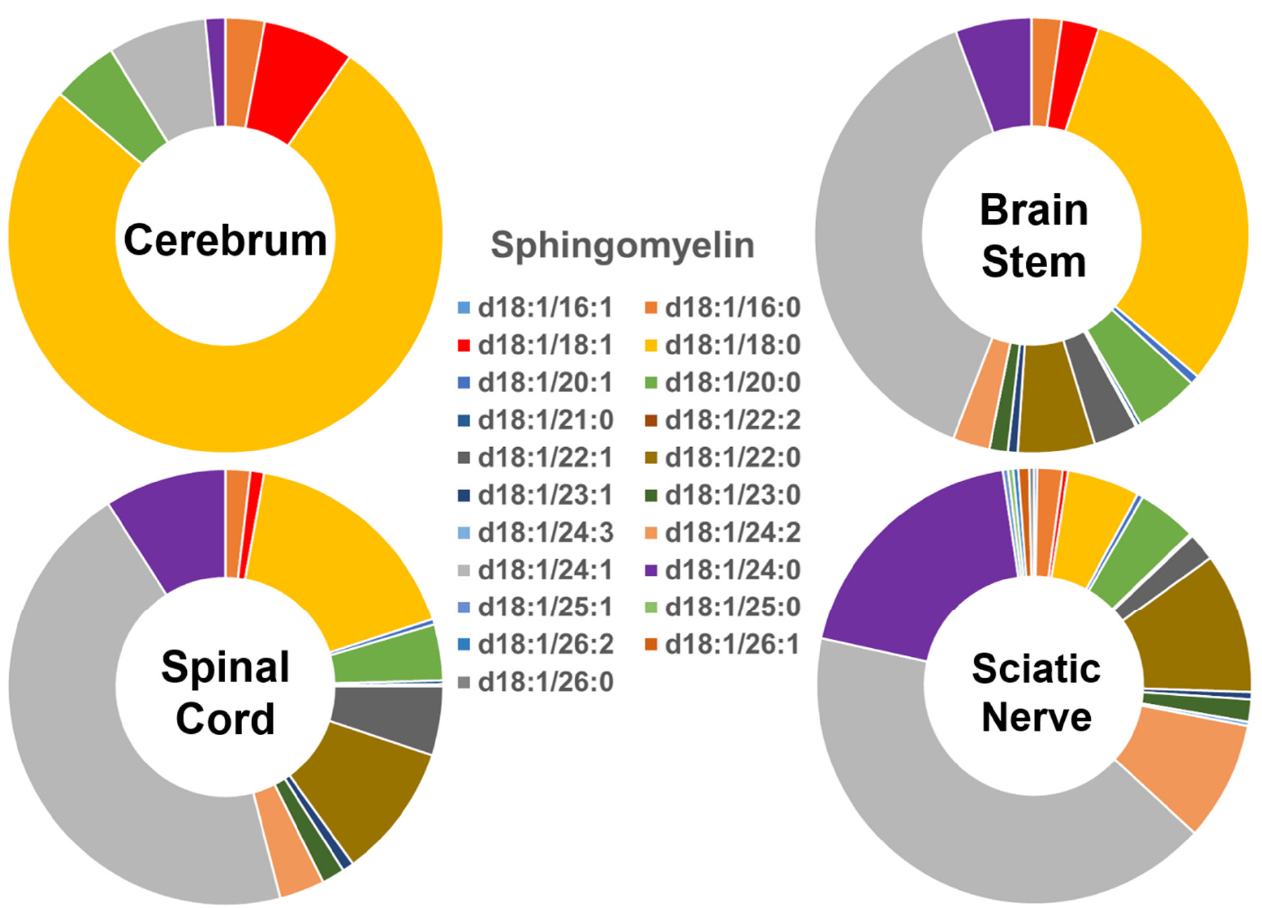
Figure 2. Comparison of sphingomyelin molecular species profiles in cerebrum, brain stem, spinal cord, and sciatic nerve tissues from 2 mo-old mice. Levels of individual sphingomyelin molecular species were assessed via shotgun lipidomics; the relative abundance of each species compared to the total class content is displayed in the form of pie graphs (Excel).